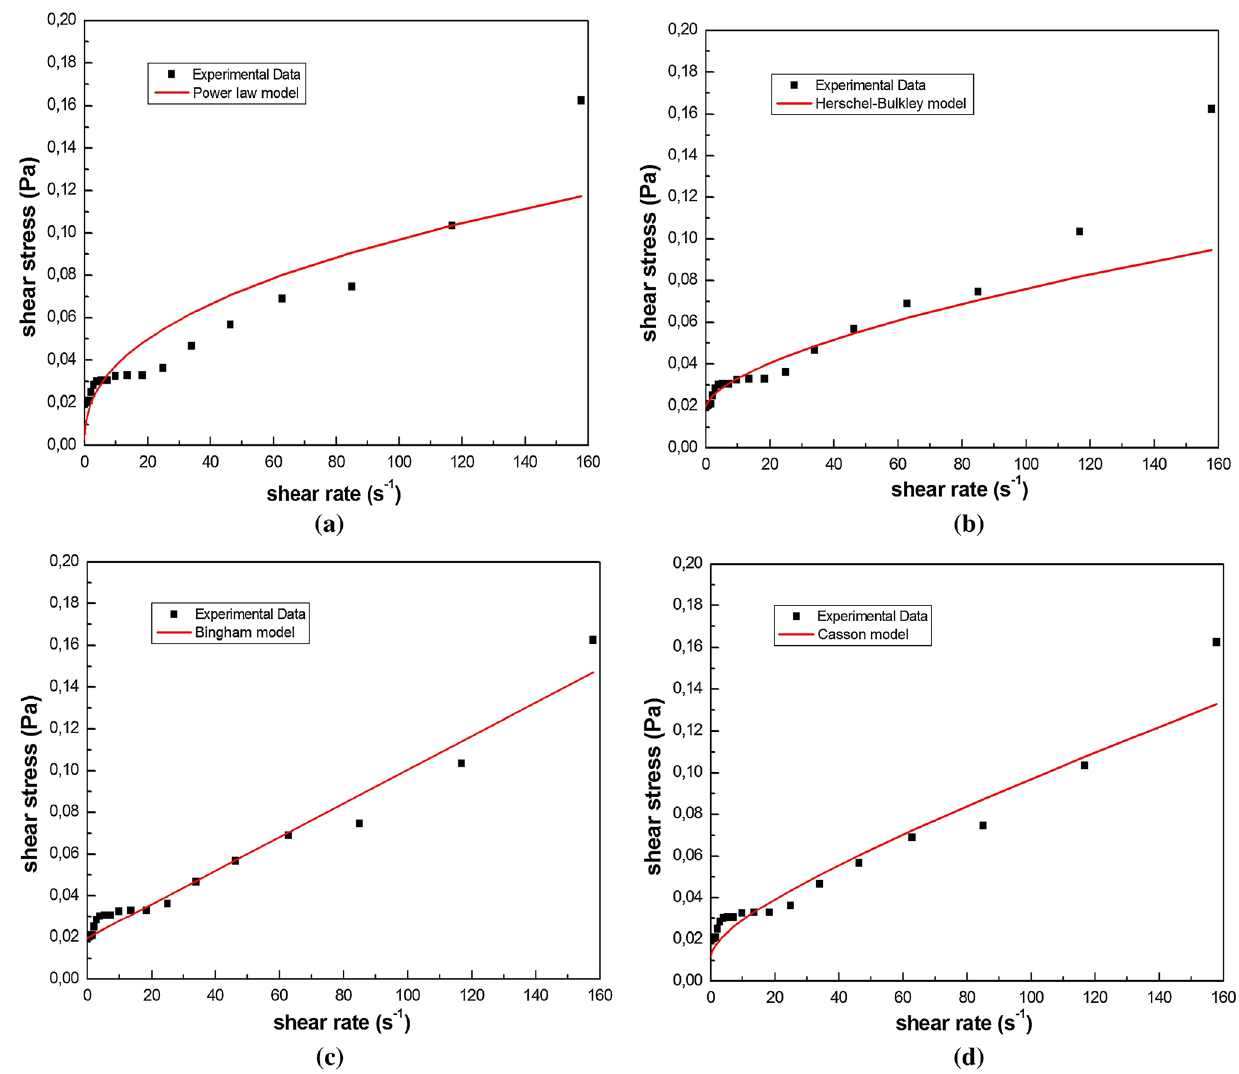
k = 0.0032; n = 0.6281; R 2 = 0.9639 ). c Bingham ting ( 𝜏 0 = 0.0194; s = 5.0% and R 2 = 0.9736 model fitting ( 𝜏 0 = 0,0196; 𝜇 B = 0.0008; ). d Casson R 2 = 0.9782 model fitting ( 𝜏 0 = 0.0111; 𝜇 0 = 0.00042 ) 2 ,